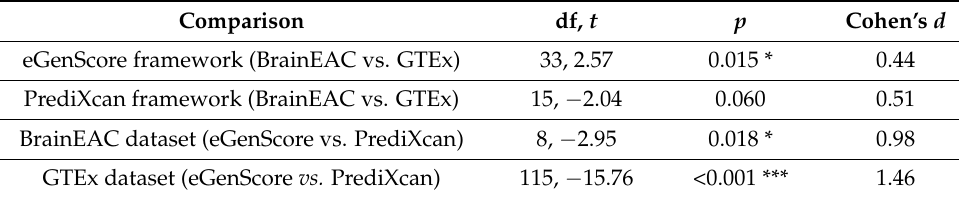
Table 2. Comparison of the gene expression models’ external validation performance (i.e., the squared Pearson correlation coefficient between the predicted and observed gene expressions in the CMC dataset) across datasets (i.e., BrainEAC vs. GTEx) and across frameworks (i.e., eGenScore vs. PrediXcan). Comparison df, t p Cohen’s d eGenScore framework (BrainEAC vs. GTEx) 33, 2.57 0.015 * 0.44 PrediXcan framework (BrainEAC vs. GTEx) 15, − 2.04 0.060 0.51 8, −